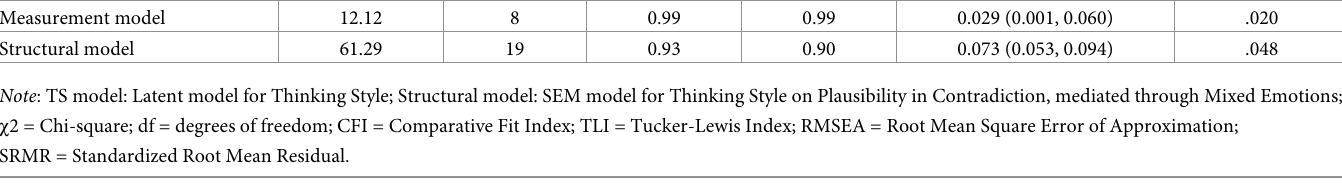
contradiction as the outcome variable, thinking style as the predictor variable, and mixed emo-